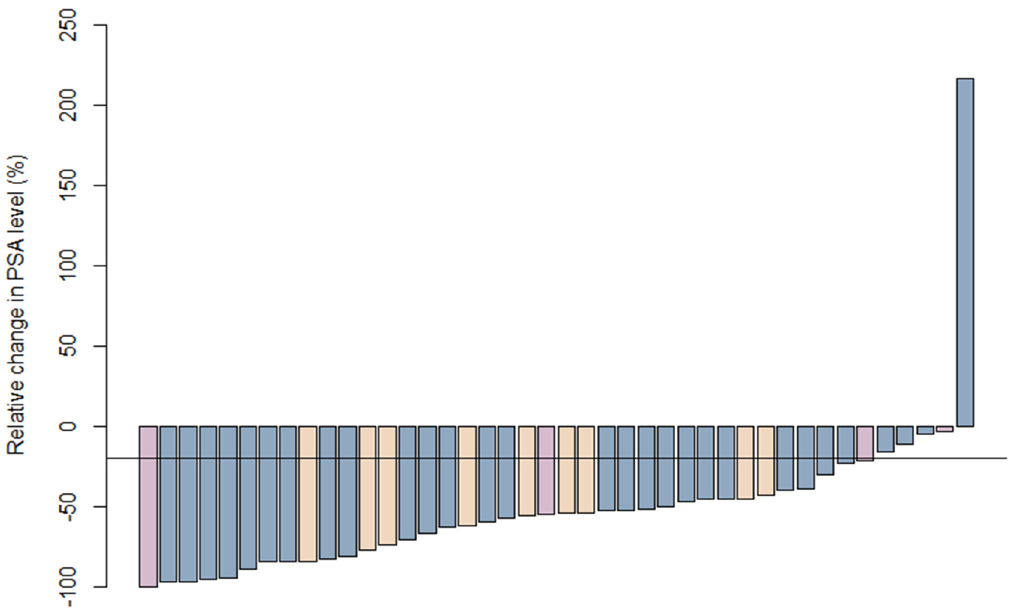
Figure 1. Relative PSA decline at three months after SBRT. Patients with a new ADT prescription are purple, and patients with ADT for more than three months are yellow. The horizontal line stands for − 20% in the change of PSA . SBRT - stereotactic body radiation therapy; PSA - prostate specific antigen.